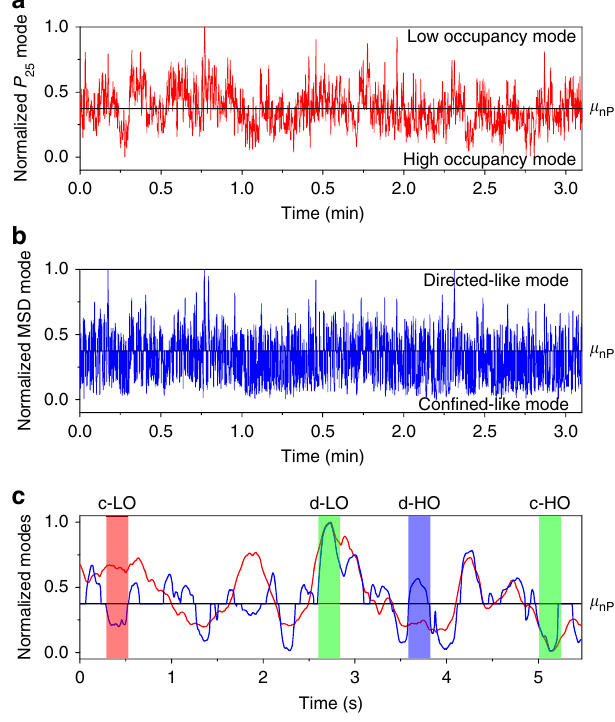
Figure 4 | Comparison of the MSD- D t and P 25 temporal profiles. ( a ) Normalized P 25 temporal profile of an experimental replicate of ColE 1 DNA. m np is the mean of the normalized P 25 profile. ( b ) Normalized temporal profile of the absolute diffusion modes (directed-like and confined-like) of ColE 1 DNA obtained from the MSD- D t plots of an experimental replicate at each time point. ( c ) Enlarged view of the superimposed normalized P 25 (red) and MSD- D t (blue) temporal profiles. The green shadings highlight the d-LO and c-HO sub-modes. The red and blue shadings highlight the c-LO and d-HO sub-modes, (10) and (11) (see Methods; Supplementary Fig. 6g,h). These